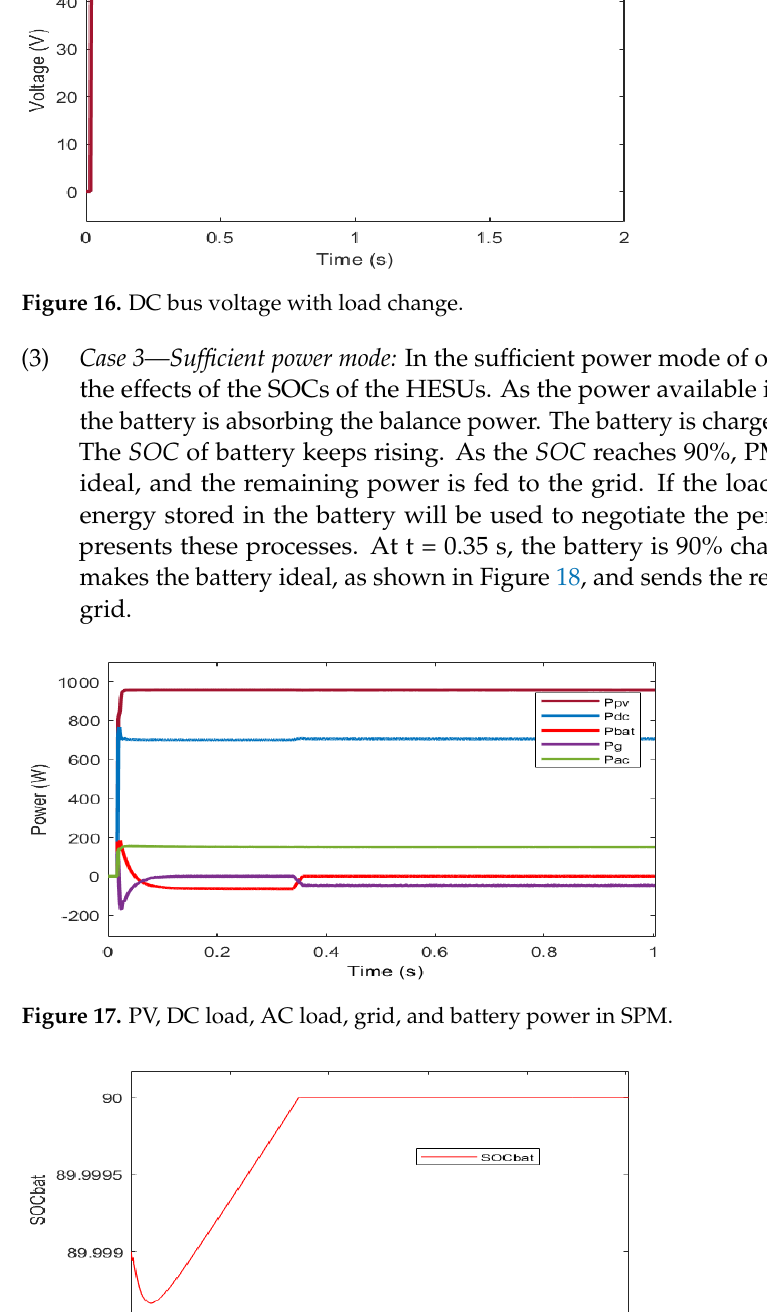
Figure 18. Battery SOC in SPM.